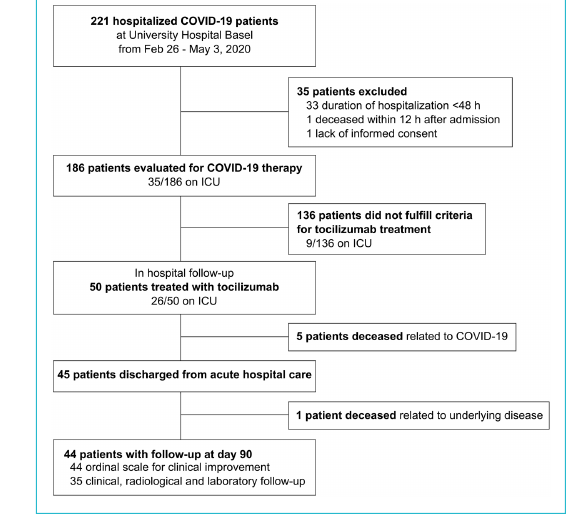
Figure 1: Profile of SARS-CoV-2 patients’ enrolment and follow-up visits.Of the 221 patients hospitalised with COVID-19 in the initial phase of the pandemic at our hospital, 50 were treated with tocilizumab. * Patients admitted to the intensive care unit (ICU) at any time point during hospitalisation. § Nine patients admitted to the intensive care unit (ICU) did not receive tocilizumab because of elevated liver enzymes (1/9), ongoing acute infection (3/9), ICU admission due to other reasons than COVID-19 (3/9), not yet es- tablished as COVID-19 treatment (1/9) or patient’s will (1/9). Clini- cal outcome based on the WHO ordinal scale was recorded on day 90 (n = 44) for all surviving patients treated with tocilizumab. Clinical, immunological and pulmonary outcomes on day 90 were evaluated in 35 of 44 surviving patients,